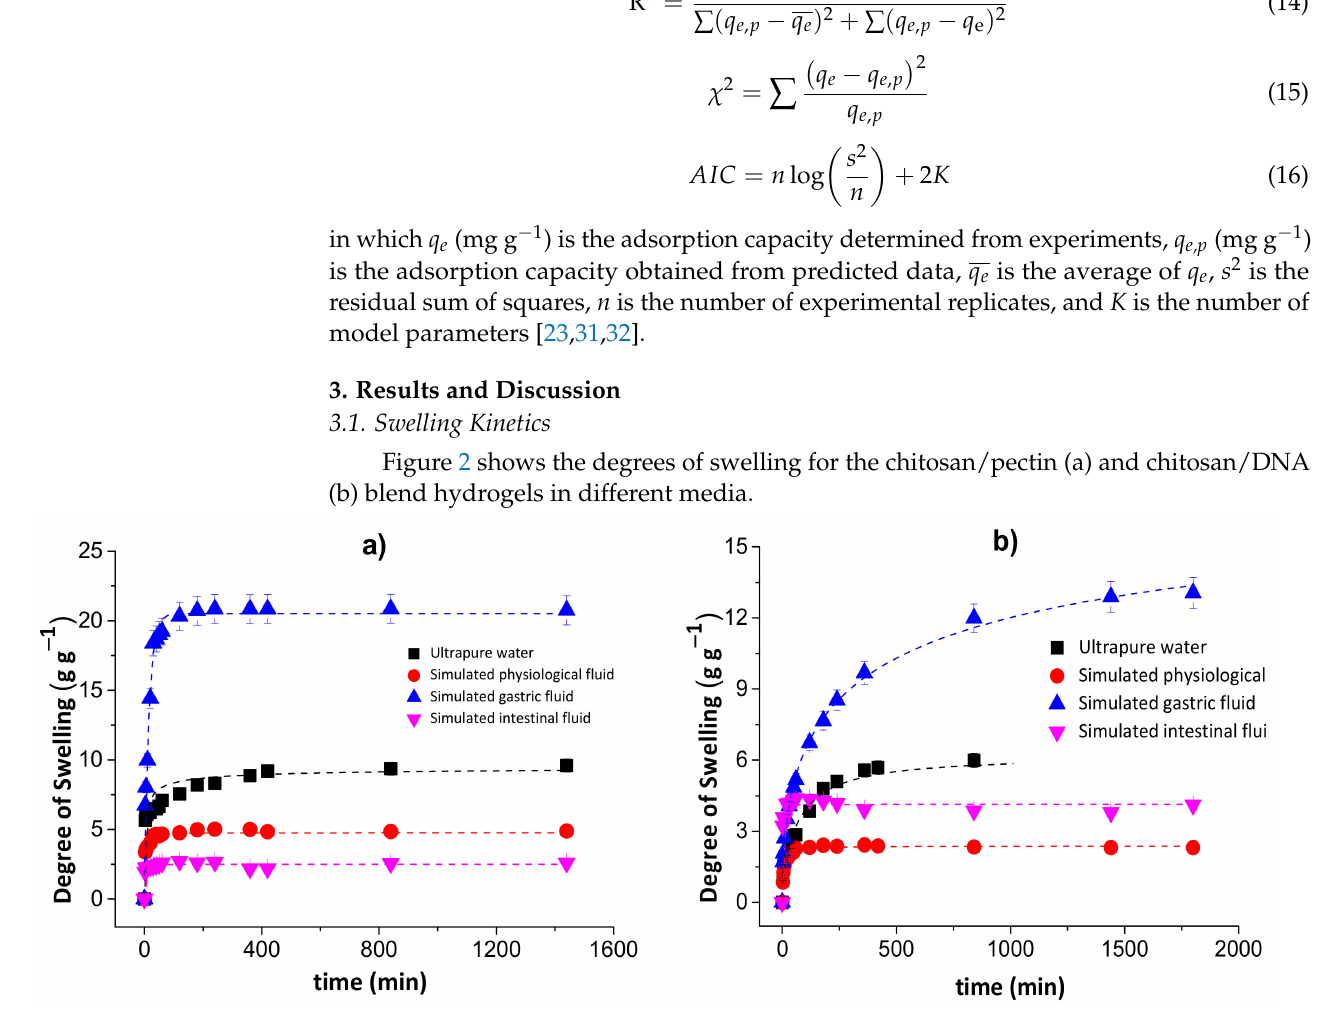
Figure 2. Degrees of swelling for the chitosan/pectin ( a ) and chitosan/DNA ( b ) blend hydrogels in different media. The degree of swelling of the chitosan/pectin hydrogel in ultrapure water was ap- proximately 9.59 g of water per g of dried chitosan/pectin gel after 1440 min. This value corresponds to 6.27 g of water per g of dried chitosan/DNA. The swelling degrees for these hydrogels in simulated physiological fluid were, respectively, 4.88 and 2.31 g g − 1 . In simulated intestinal fluid, the DS for CPB and CDB were: 2.559 and 4.254 g g − 1 ,